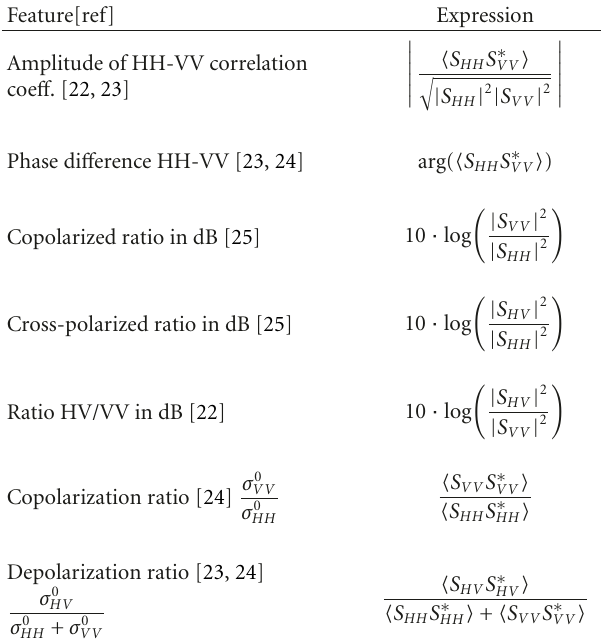
Table 1: Polarimetric parameters considered in this work. Feature[ref]